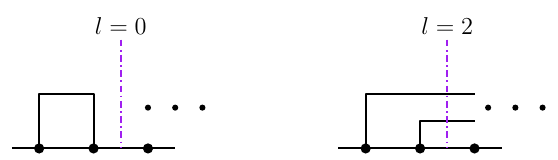
Figure 4. An example for partial open chords, until stage 2.